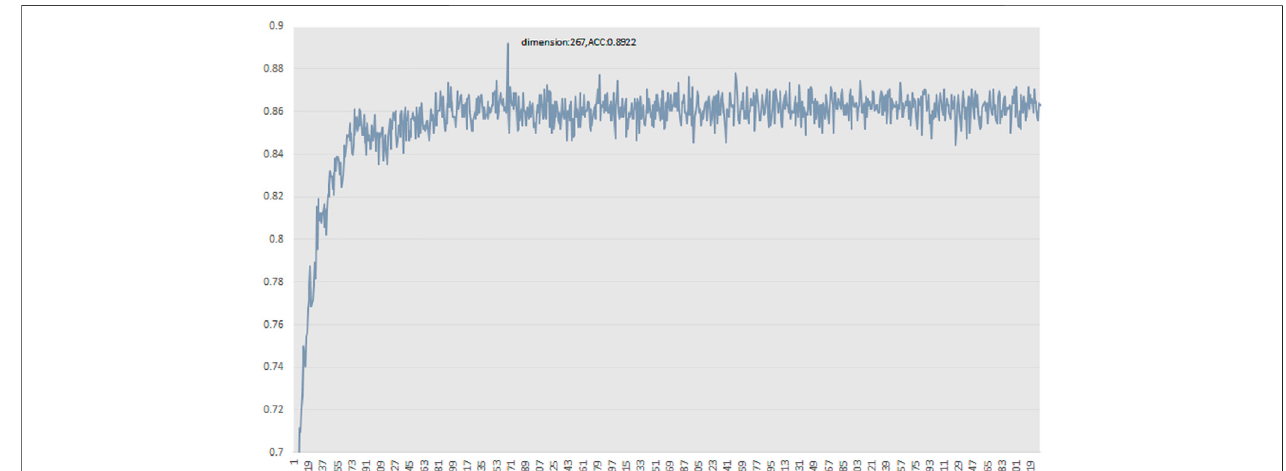
FIGURE 3 | Prediction accuracy curve of feature